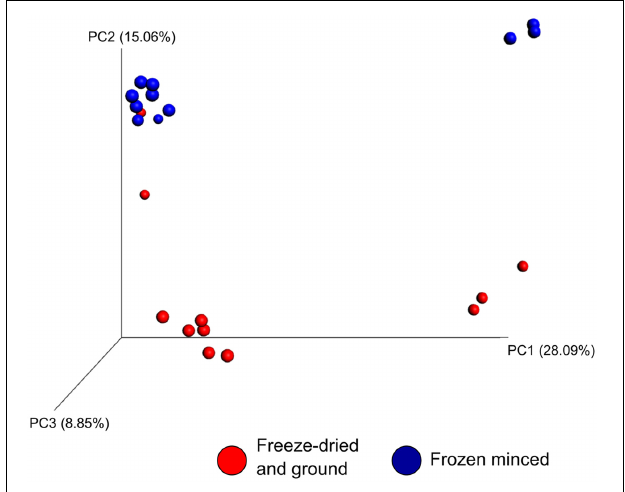
FIGURE 5 | Principal coordinate analysis of the unweighted UniFrac distances for forage preparation for both LAM and SAM samples. The percent variation explained by each principal coordinate is indicated on the axes. No rumen samples included LAM, liquid-associated microbes; SAM, solid-associated microbes.